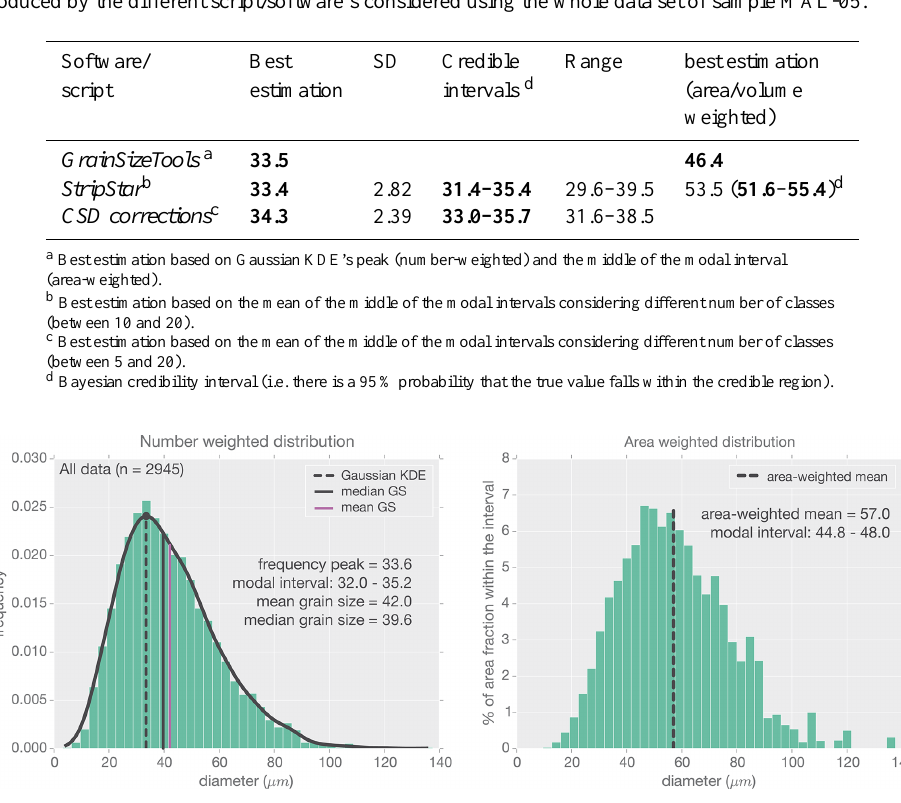
Figure 9. Results of GrainSizeTools script using the full data set from the natural sample